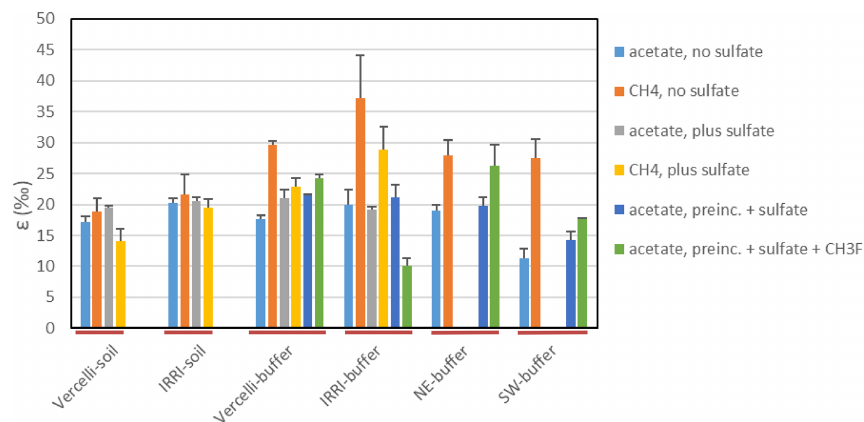
Figure 3. Isotopic enrichment factors ( ε ac or ε CH , given as negative values) of unbuffered soil suspensions (Vercelli soil and IRRI soil) and 4 buffered suspensions of paddy soil (Vercelli and IRRI) or sediments of Lake Fuchskuhle (northeastern and southwestern basins). The values of ε ac (acetate) and ε CH (CH 4 ) were measured without the addition of sulfate (methanogenic conditions), with the addition of sulfate during 4 preincubation and the experiment (sulfidogenic conditions), and with sulfate but the preincubation without sulfate (mostly methanogenic conditions). Mean ± SE, n =